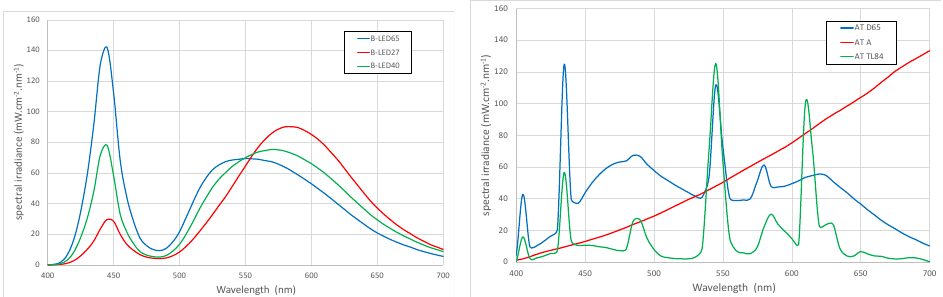
Figure 2. SPDs of test light sources in the two test booths. Left : light booth I and right : light booth II. In the figure: BLED65, BLED40, and BLED27 representing the light sources with nominal CCT 6500 K, 4000 K, and 2700 K respectively for light booth I; and Daylight (Simulator D65), TL84 (Tri-band fluorescent tube), and A (Tungsten lamp) representing the light sources with nominal CCT values of 6500 K, 4000 K, and 2700 K respectively for light booth II.